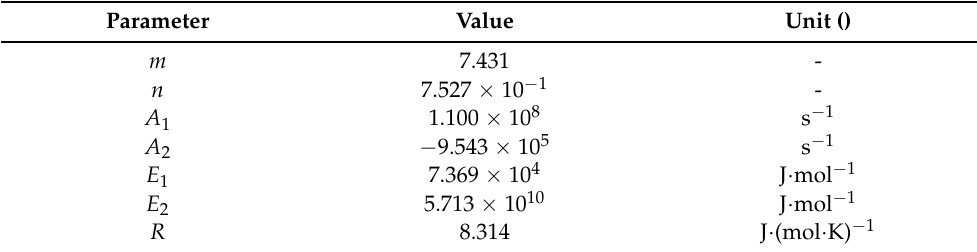
Table 3. Parameter values for the Kamal-Sourour kinetic model fitted to isothermal DSC data.